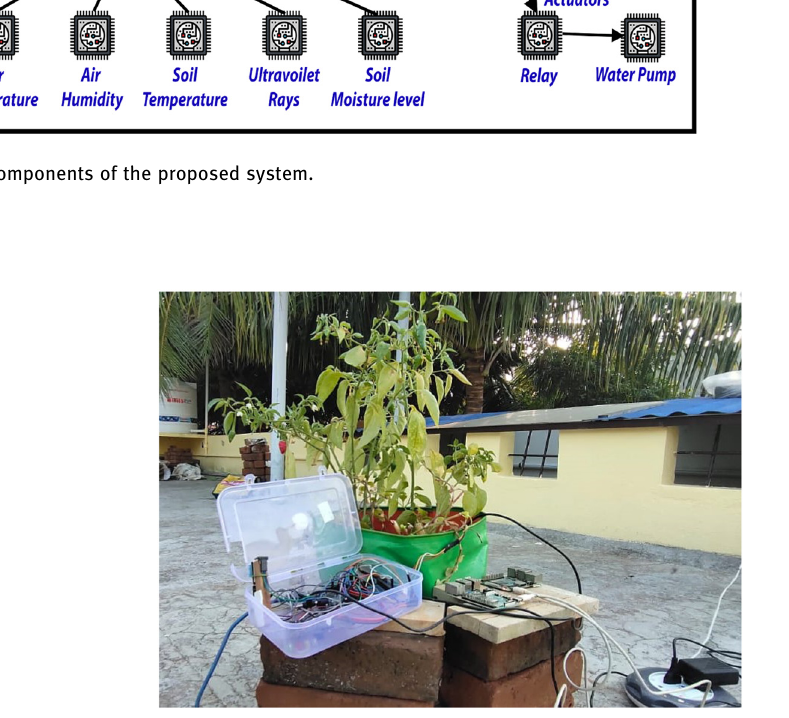
Light Sensor Module. An Arduino Mega connected to Raspberry Pi 4 Model - B read, the output of these sensors where the program is developed in Python for the Pi model to fetch the hourly data from sensors and store the data in MongoDB [ 27 ] database. It is then synchronized with the server database using the developed web service. A Wi - Fi - enabled Arduino controls the water pump connected to a relay switch.